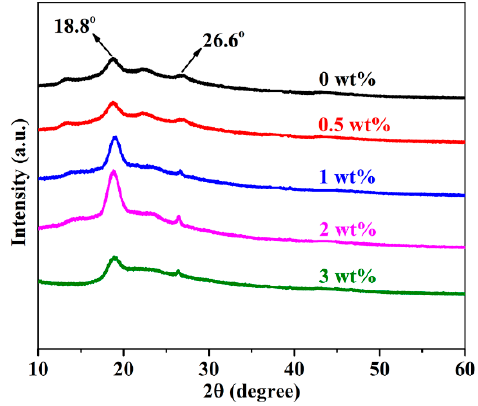
Figure 8. WAXD patterns of various h-BN@(PDA+PEI)/PEN nanocomposite films. Table 2. The crystallinity of PEN nanocomposites with various h-BN@(PDA+PEI) contents. Sample